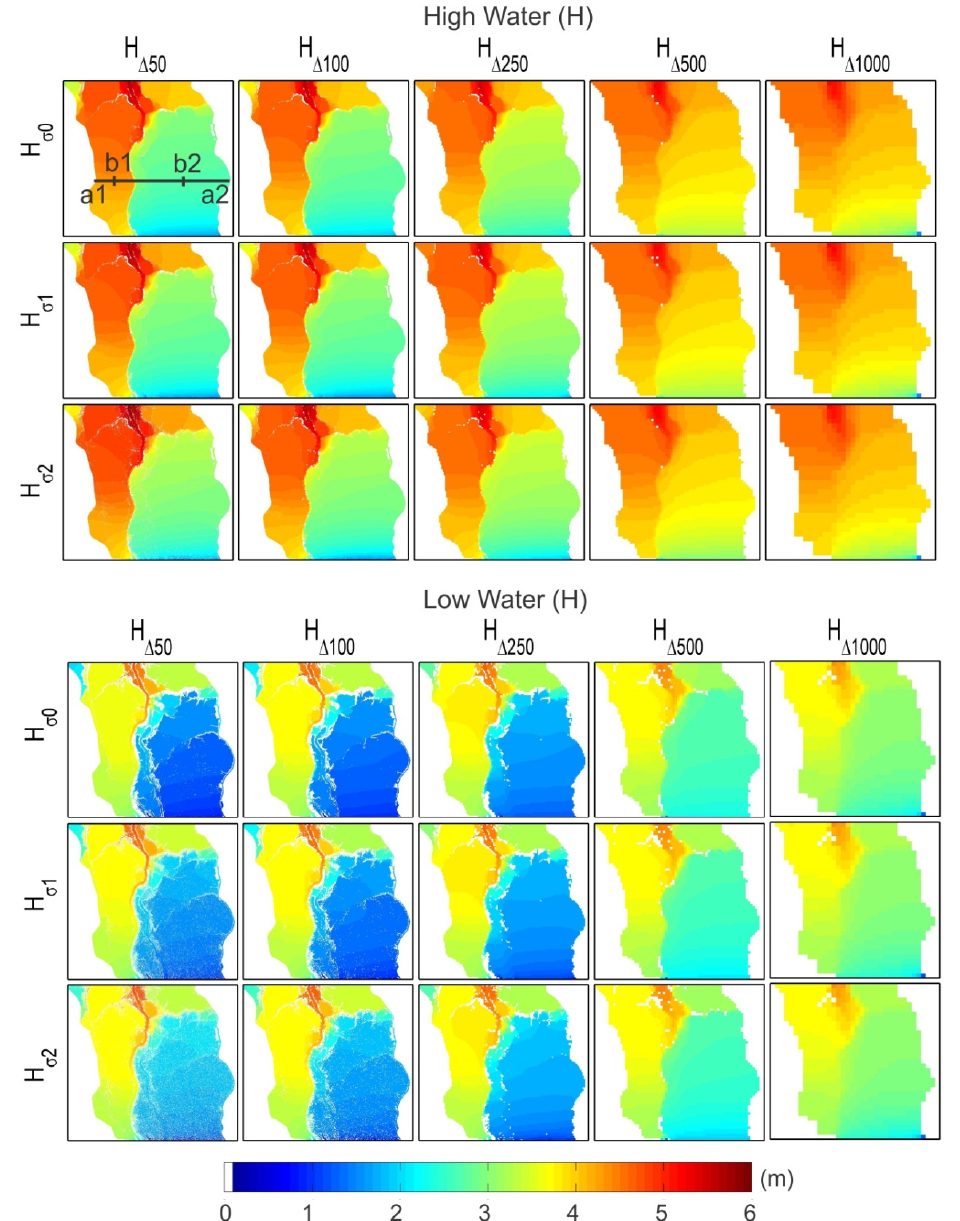
Figure 3. Water elevation (H) maps on both high water day (28) and low water (day 62). Water elevations along profile a1-a2 are represented in Figure 4. Locations b1 and b2 are used to calculate the water elevation RMSEs in Figure